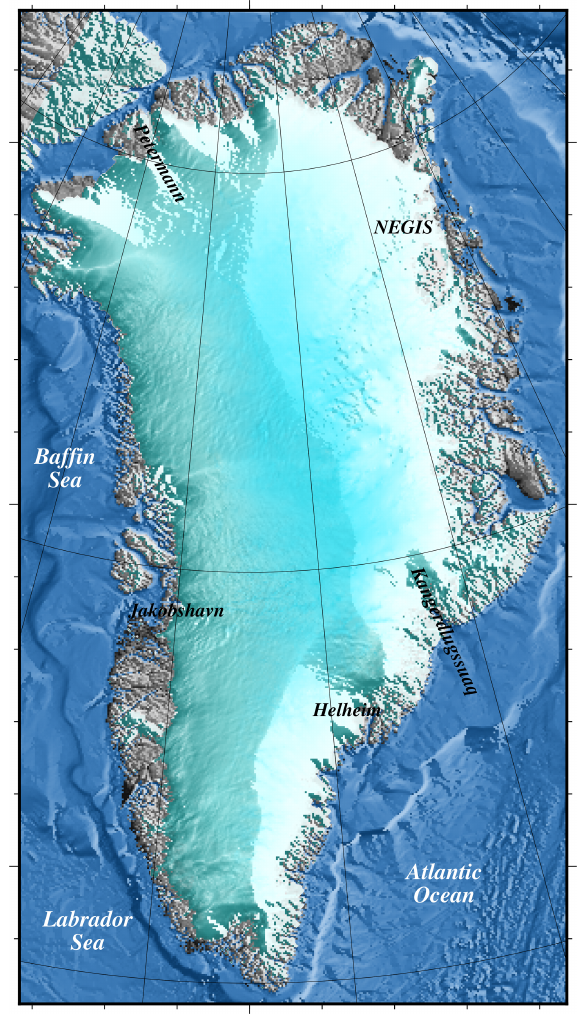
Figure 1. The Greenland ice sheet with the major ice streams dis- cussed in the